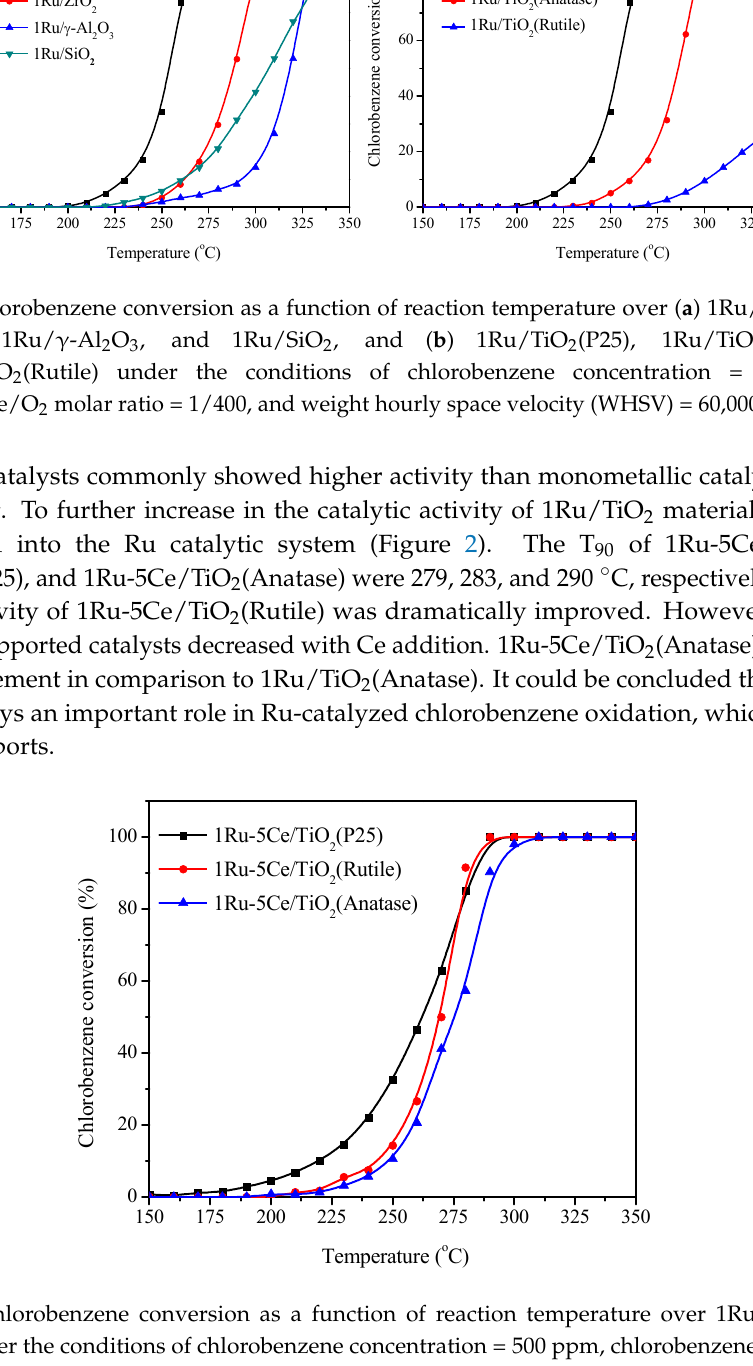
Figure 2. Chlorobenzene conversion as a function of reaction temperature over 1Ru ‐ 5Ce/TiO 2 catalysts under the conditions of chlorobenzene concentration = 500 ppm, chlorobenzene/O 2 molar ratio = 1/400, and WHSV = 60,000 mL/(g h).